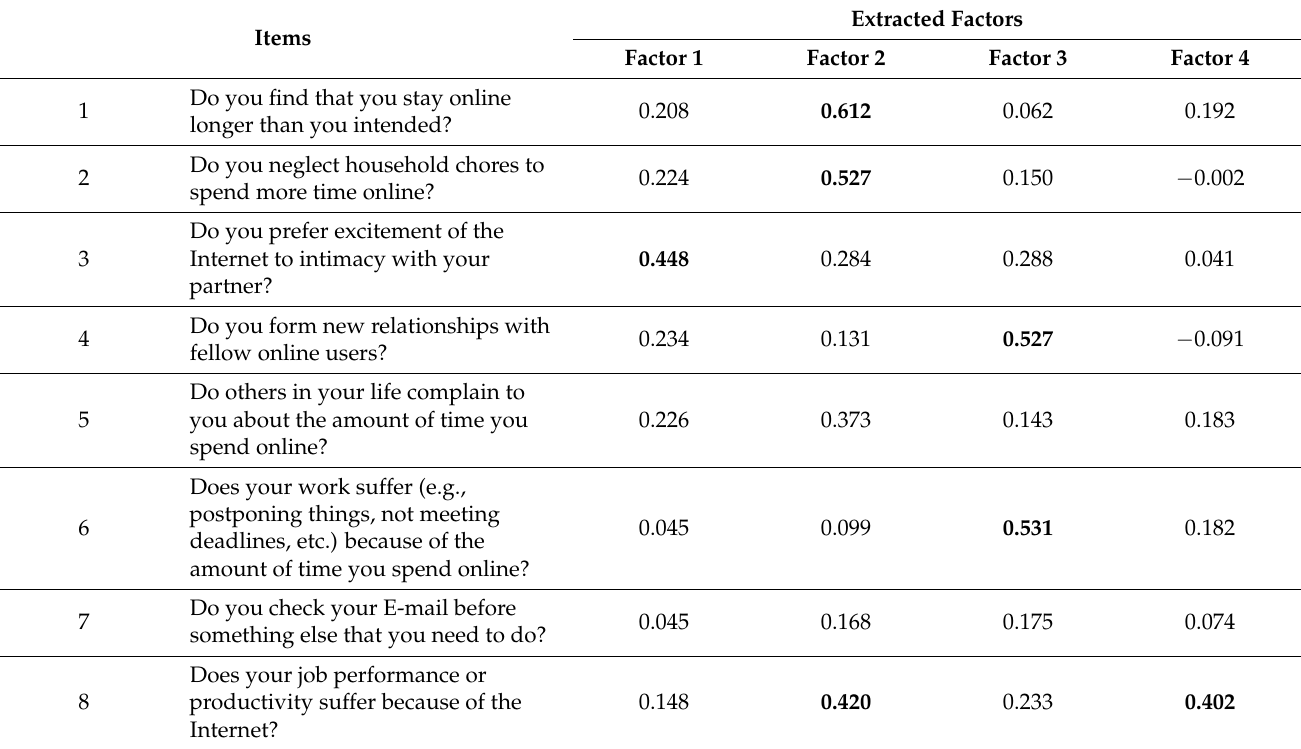
Table 3. Item loadings on corresponding factors as revealed by exploratory factor analysis of the Internet Addiction Test (IAT) in the school children